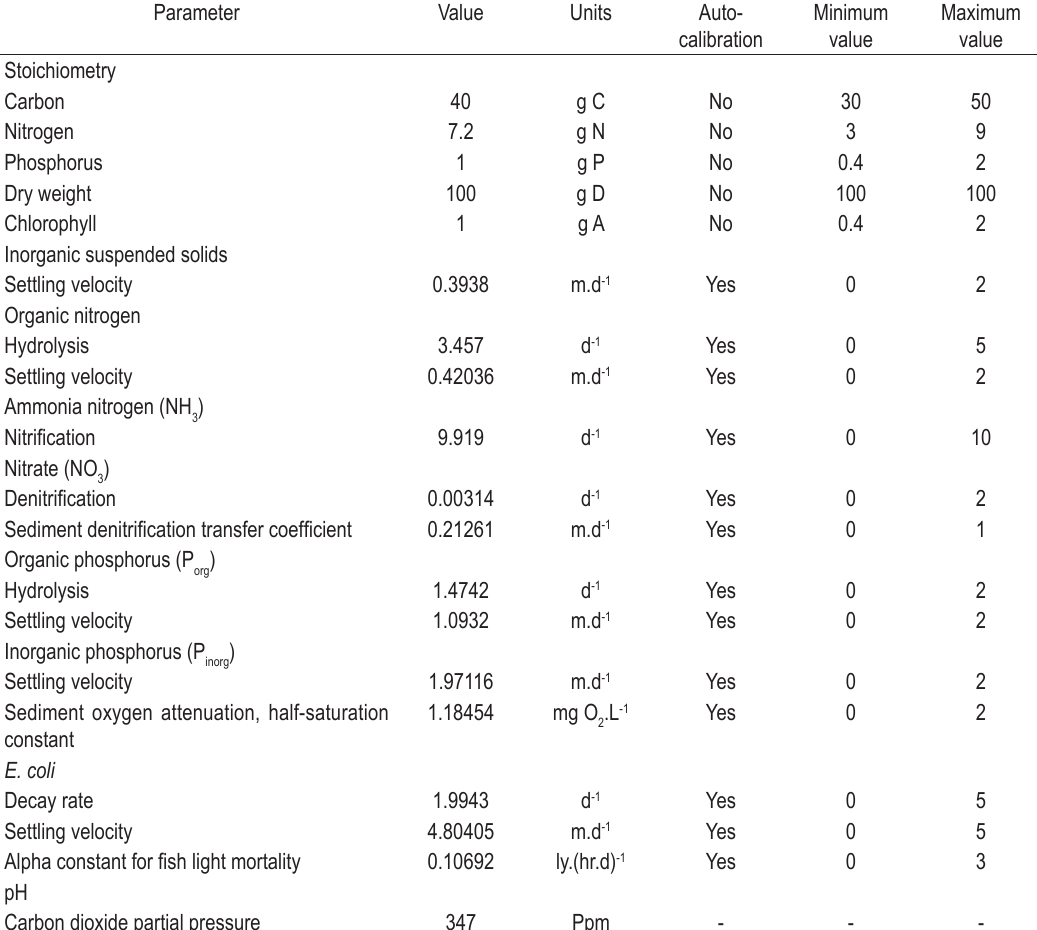
Table 2. Kinetics parameters used in modeling of the Fidalgo Stream.